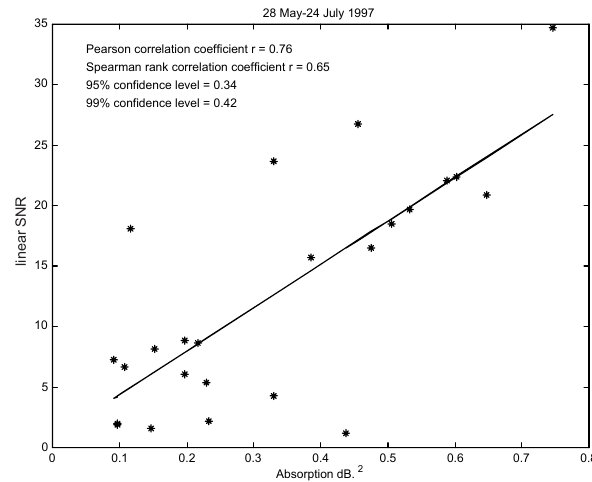
Pearson correlation coefficient r = 0.76 Spearman rank correlation coefficient r = 0.65